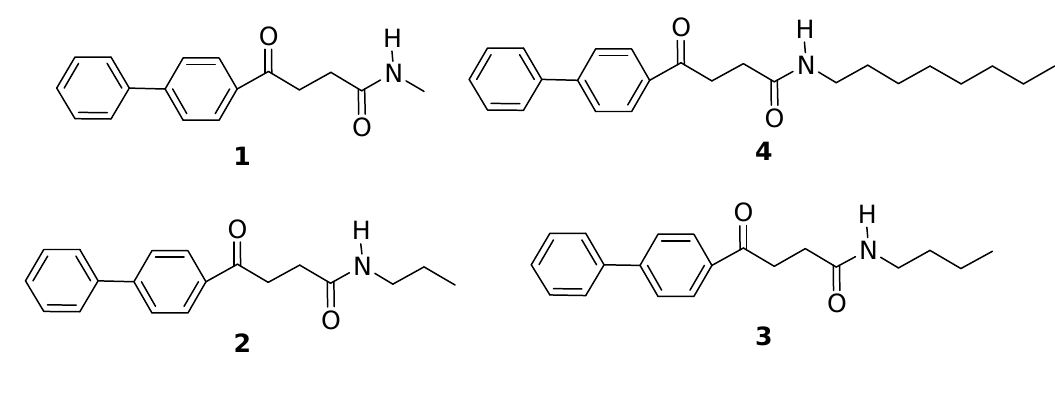
Figure 1. Fenbufen amide analogs: methyl fenbufen ( 1 ); propyl fenbufen ( 2 ); butyl fenbufen ( 3 ); octyl fenbufen ( 4